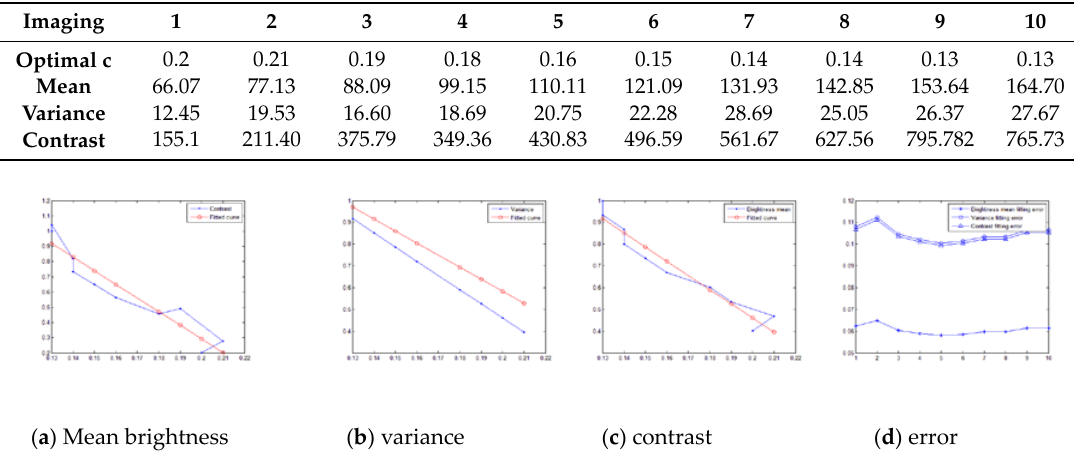
Table 2. Mean brightness, variance , contrast and optimal c value of the original image.